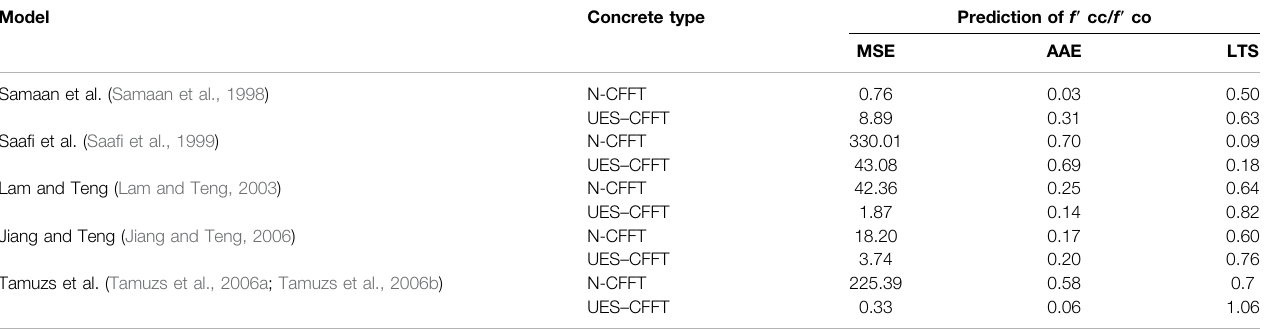
TABLE 9 | Statistics on models of strength enhancement ratios of test